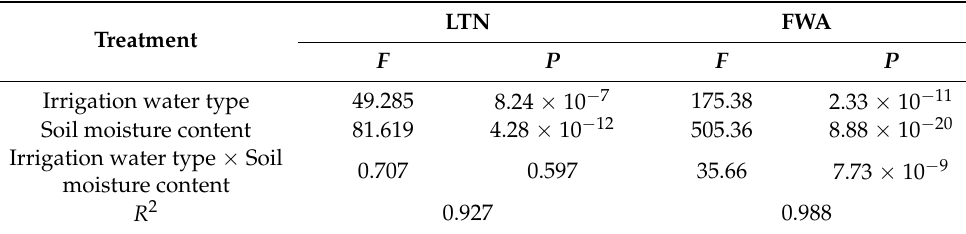
Table 3. Analysis of variance of the total nitrogen in spinach leaves, fresh weight of aerial parts, and interaction between irrigation water type and soil moisture